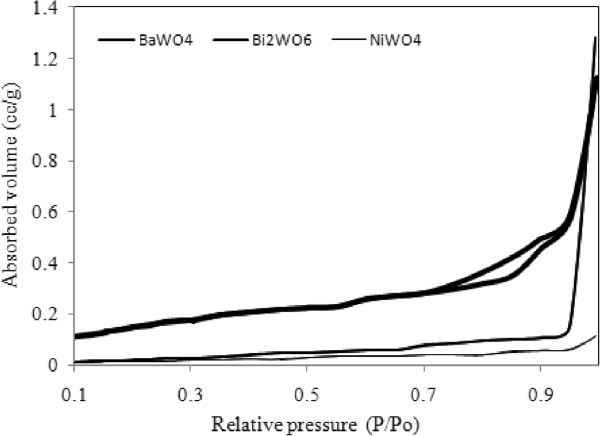
N2 adsorption isotherms of BaWO4, Bi2WO6 and NiWO4 samples.